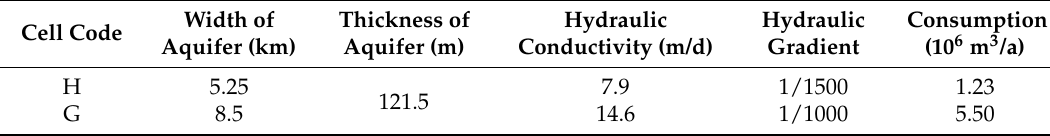
Table 3. Lateral groundwater discharge of Cells G and H.